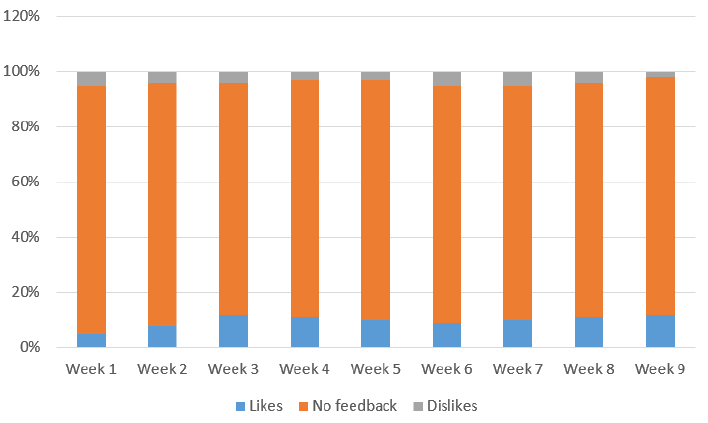
Figure 9. Like to dislike ratio over the whole admission